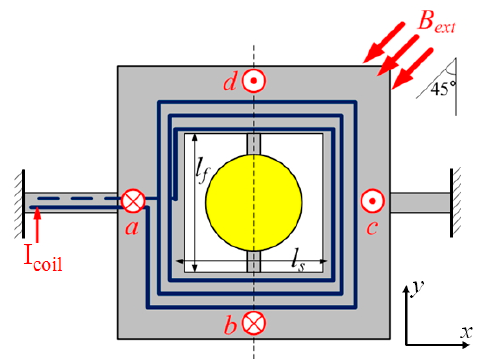
Figure 1. Top view schematic of the bi-axial scanning mirror design.